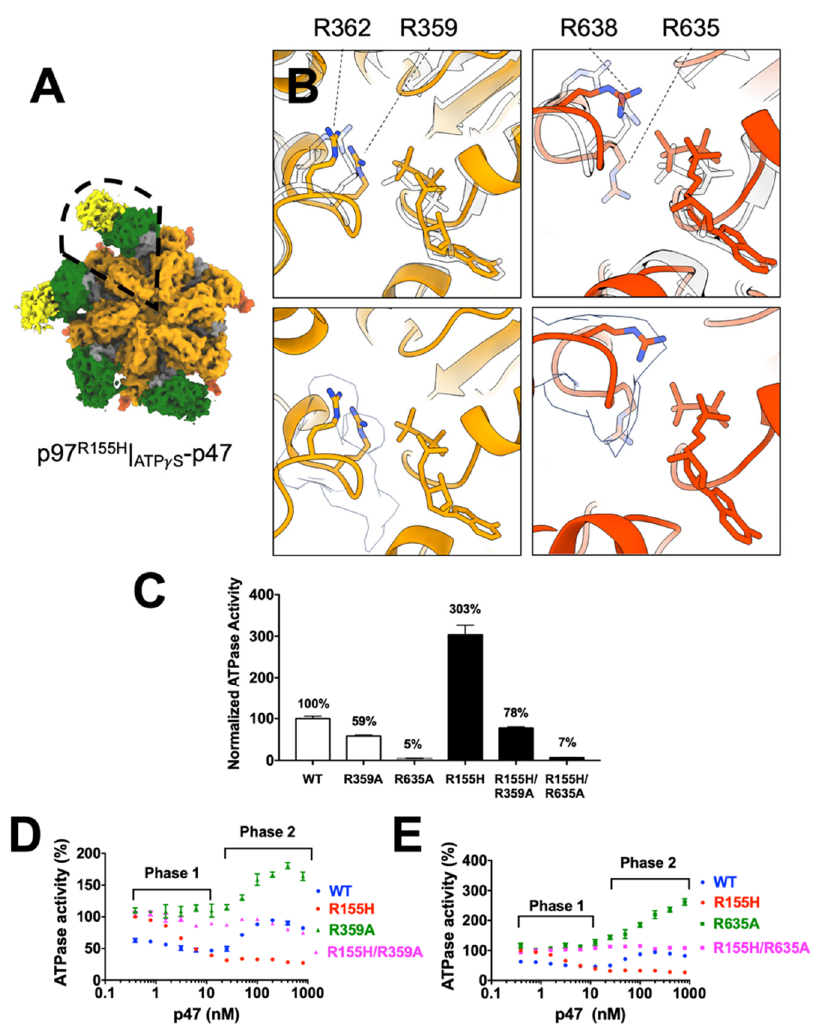
Figure 4. Cryo-EM structural analysis of the p97 R155H | ATP γ S -p47 complex and functional measurements of the p97 arginine finger mutants. ( A ) Cryo-EM density of the p97 R155H | ATP γ S -p47 complex. Color coding is the same as those in Figure 2. Enclosed is the p97 R155H | ATP γ S -p47 monomer used for structural comparison with p97 WT | ATP γ S . ( B ) Superposition of the structures of p97 R155H | ATP γ S -p47 and p97 WT | ATP γ S (PDB code: 5FTN) [37]. Bound ATP γ S and arginine fingers are shown in stick representation. Upper panels are the superpositions of the two structures and white are the p97 WT | ATP γ S structure. Lower panels are the map-model fitting of the two arginine fingers in D1 and D2 nucleotide-binding sites. White surfaces are cryo-EM densities. ( C ) Full-length (FL) p97 ATPase activities of wild type and R155H mutants. Activity measurements were normalized relative to the p97 WT activity and measured in the presence of 200 µM ATP ( n = 4). ( D ) Normalized ATPase activities of p97 ATPase: WT (blue circles), R155H (red circles), R359A (green triangles) and R155H-R359A (magenta triangles). The R359A mutation is located in the D1 arginine finger. p97 ATPase activity was normalized relative to its basal activity in the absence of p47. The addition of p47 increased from 0 to 800 nM. ATPase activity measurements were performed in the presence of 200 µM ATP. ( E ) Experiments as in ( B ), but the mutated residue was located at the R635A, the D2 arginine finger. p97 ATPase activity in R635A and R155H-R635A mutants is shown in green squares and magenta squares, respectively. All error bars indicate ±SD ( n = 4).